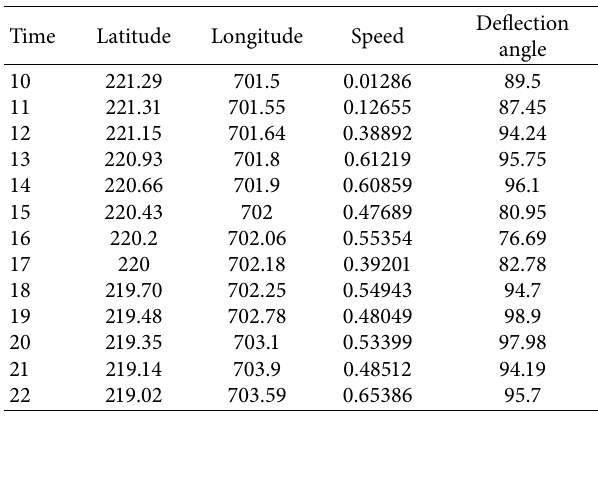
Table 2: GPS data after processing.